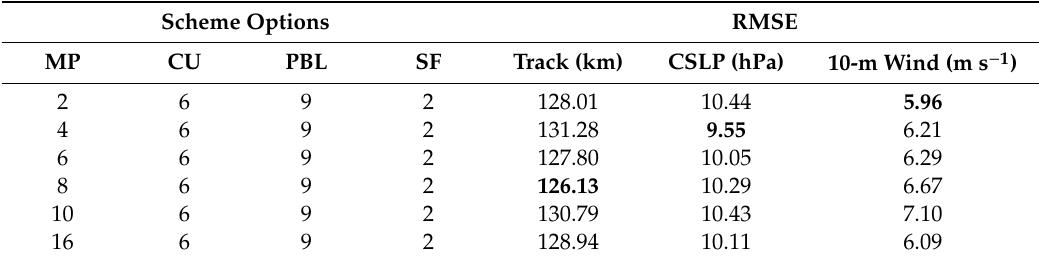
Table 5. Summary of the errors obtained with the six di ff erent scheme combinations using each of the six MP schemes, the optimal CU, and the optimal PBL scheme. Bold values represent the optimal variable